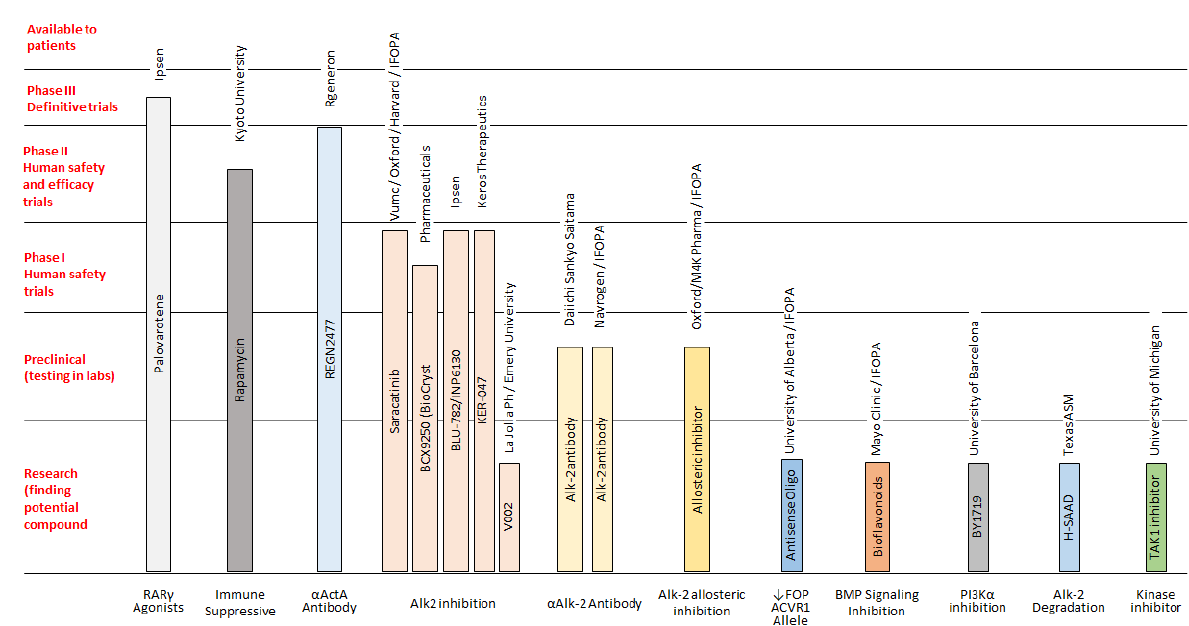
Figure 3. FOP therapeutic pipeline: drugs in research and development [15 – 25].